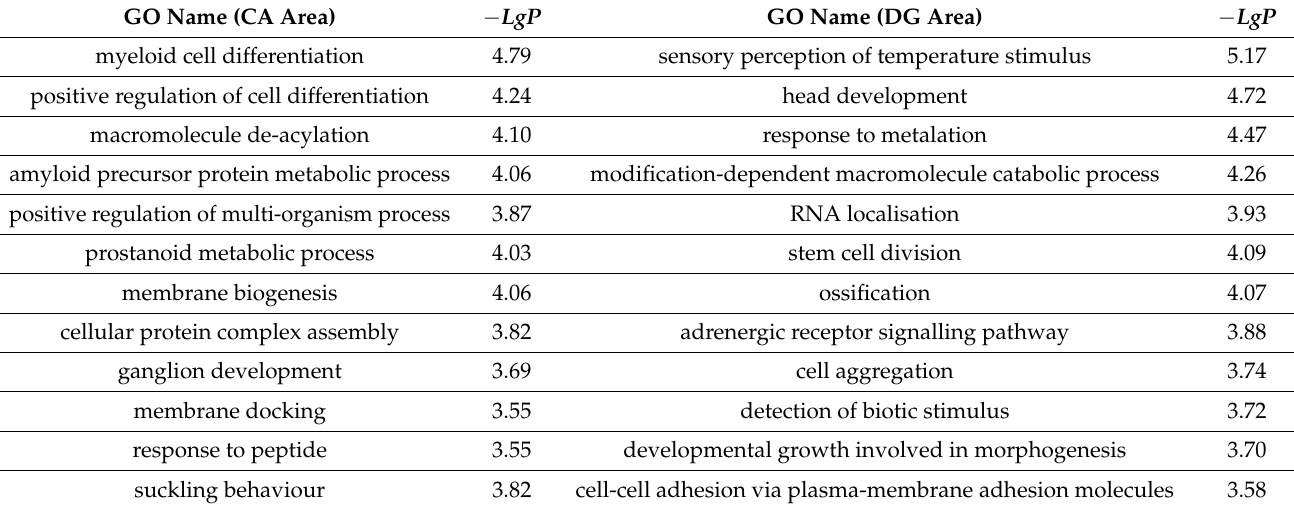
Table 4. Different functions regulated by changed miRNAs in CA and DG areas.